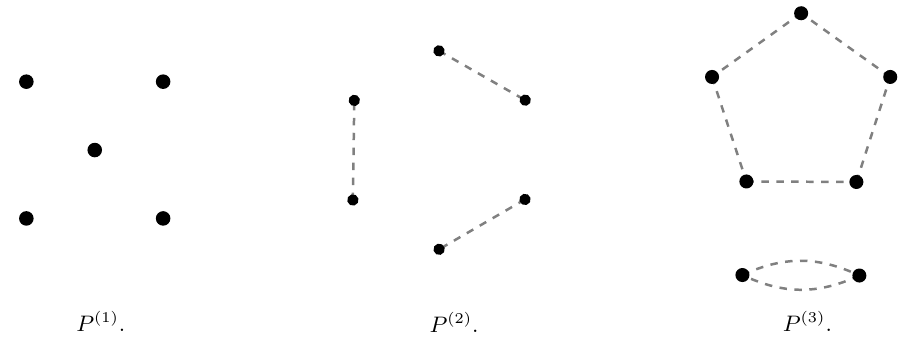
Figure 1. Here we draw examples of the P -graphs for the numerator polynomials P ( L ) with L = 1 , 2 , 3 , they are taken from figure 1 in [17]. As one can see that each P ( L ) -graph has ( L + 4) vertices, and each vertex has degree ( L − 1)